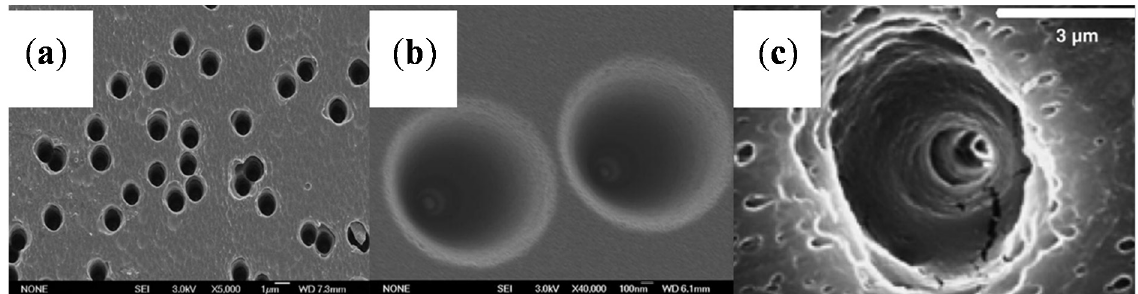
Figure 2. Scanning electron microscopy (SEM) images of the wide opening side on the polymer